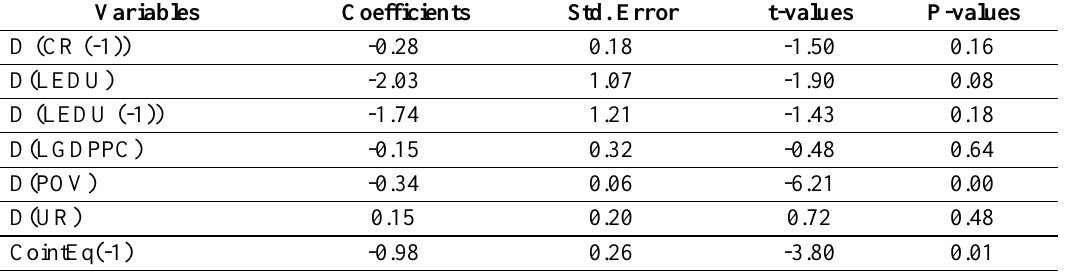
Table.6. Short-run Results using ARDL Approach